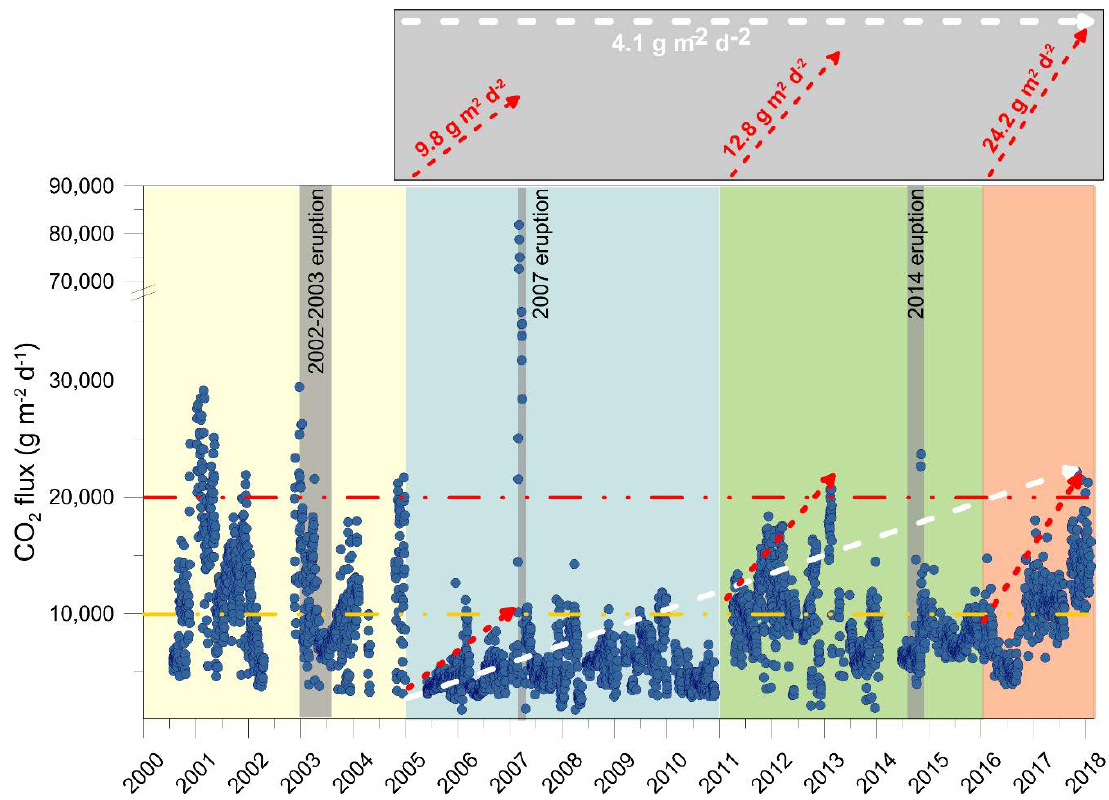
Figure 2. Daily average (24 measurements / day) of CO 2 fluxes at STR02 station, 2000–2018 period. The entire period was grouped into four sub-periods of five years each, except for the last period 2016–2018 (26 months). The first three periods include the e ff usive eruptions that took place in 2002–2003, 2007, and 2014. The long growing trend of 4.1 g · m − 2 · d − 2 (white dashed line, 2005–2018) and the short-term changes of CO 2 degassing (red dashed lines, 9.8, 12.8, and 24.2 g · m − 2 · d − 2 , respectively) have been